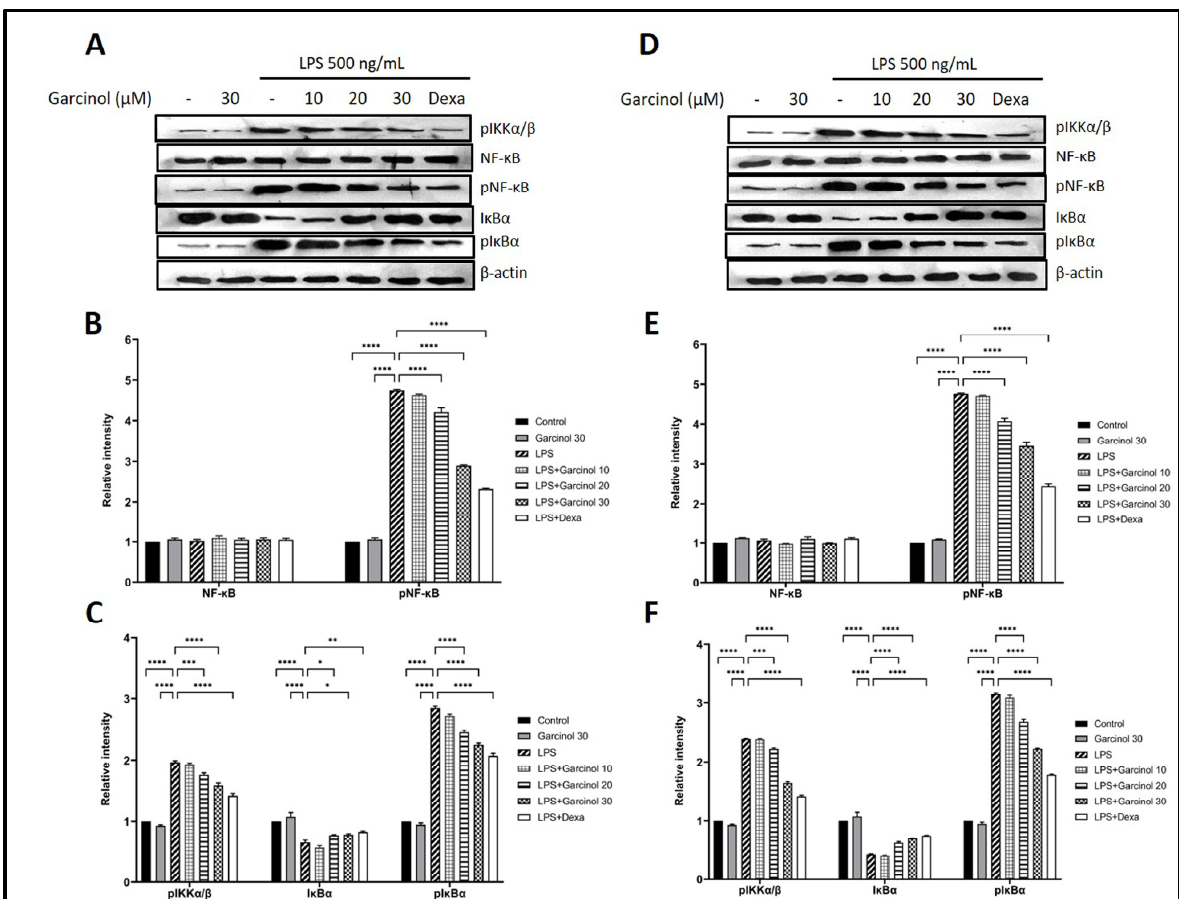
Figure 6. Effects of garcinol (10, 20, and 30 µ M) on the expression of related-molecule in the NF- κ B signaling pathway in LPS-treated THP-1 cells ( A – C ) and RAW264.7 cells ( D – F ) were determined by using western blot analysis. β -actin was used for normalization. The data are presented as the mean ± SD of triplicate examination in three independent experiments ( n = 9). For statistical analyses, One-way ANOVA and Dunnett’s test were used. * p < 0.05, ** p < 0.01, *** p < 0.001, **** p < 0.0001.